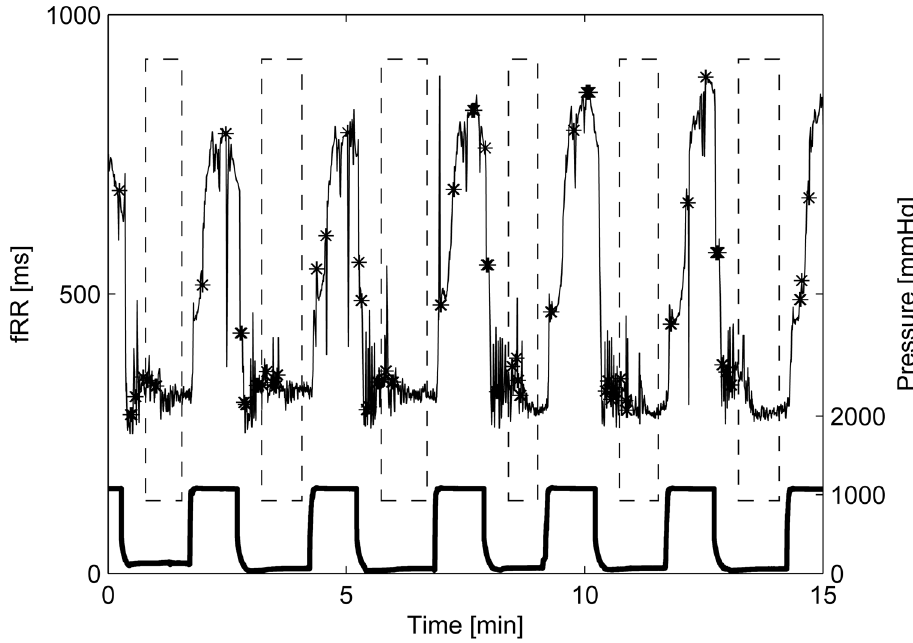
Figure 1. Example of fRR series and umbilical cord occlusions (UCOs) pressure signal (bottom bold line). Dashed boxes emphasize stable fRR intervals (without artifacts and UCO-induced decelerations). Black stars mark artifacts or reconstructed fRR samples, excluded from being anchor points in the PRSA analysis.